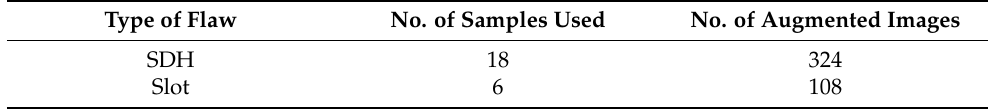
Table 2. Flaw wise augmented images for training.